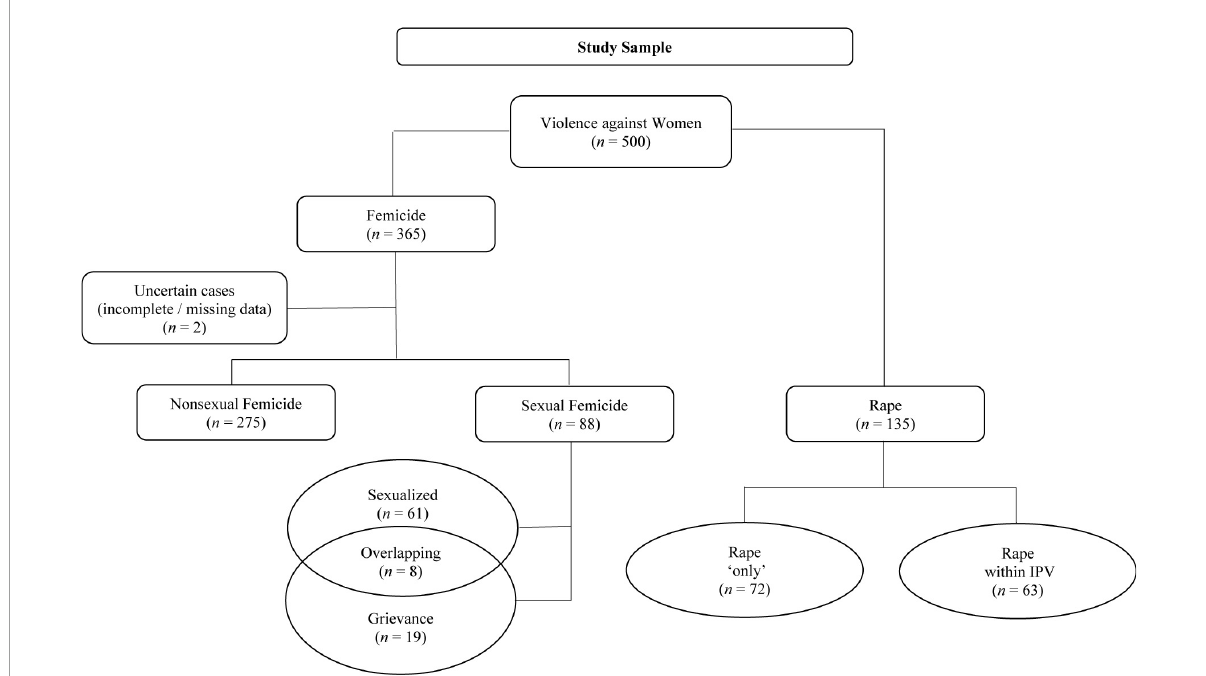
FIGURE1 Flow diagram of different forms of violence against women involved in the study